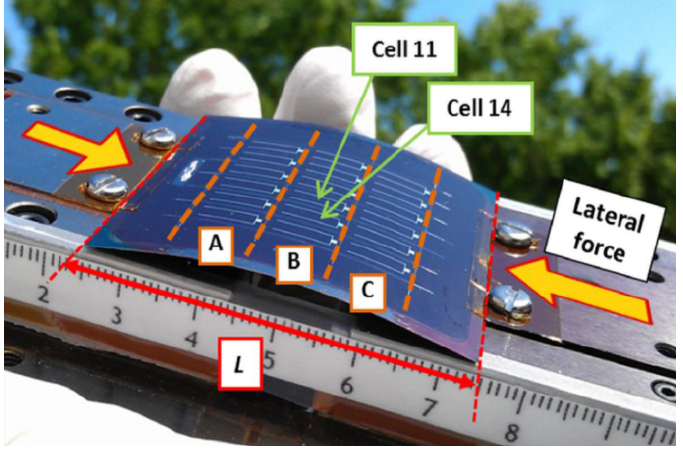
Figure 15. Bending test of a CIGS solar cell on flexible borosilicate ultra-thin glass substrate (100 µ m)